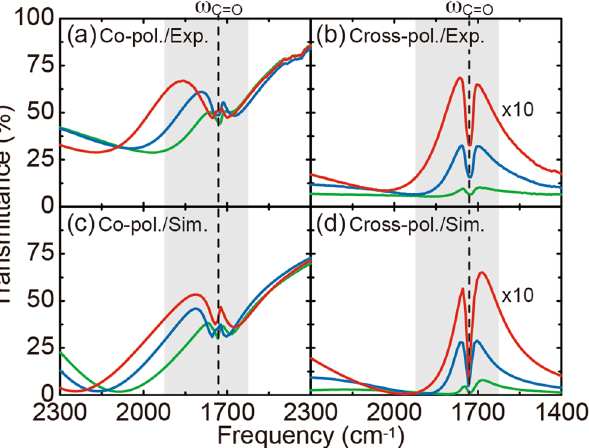
Figure 4. Polarized metamaterial-enhanced IR absorption. Experimentally measured transmission spectra of a 50-nm thick PMMA film on the metamaterials for the ( a ) co- and ( b ) cross-polarizations. ( c , d ) Corresponding numerical simulations, which well reproduced the experimental results qualitatively and quantitatively. The resonant coupling of the Fano and C = O modes at ω C = O , indicated by the dashed lines, results in an anti- resonant peak (dip) for the co- (cross-) polarization within the Fano-line shapes of the metamaterials. The cross-polarized detection scheme selectively extracts the light interacting with the metamaterial-molecular coupled system, thus dramatically improving the vibrational signal contrast compared to the conventional co- polarized case. The spectra in ( b ) and ( d ) have been multiplied by 10 for clarify.